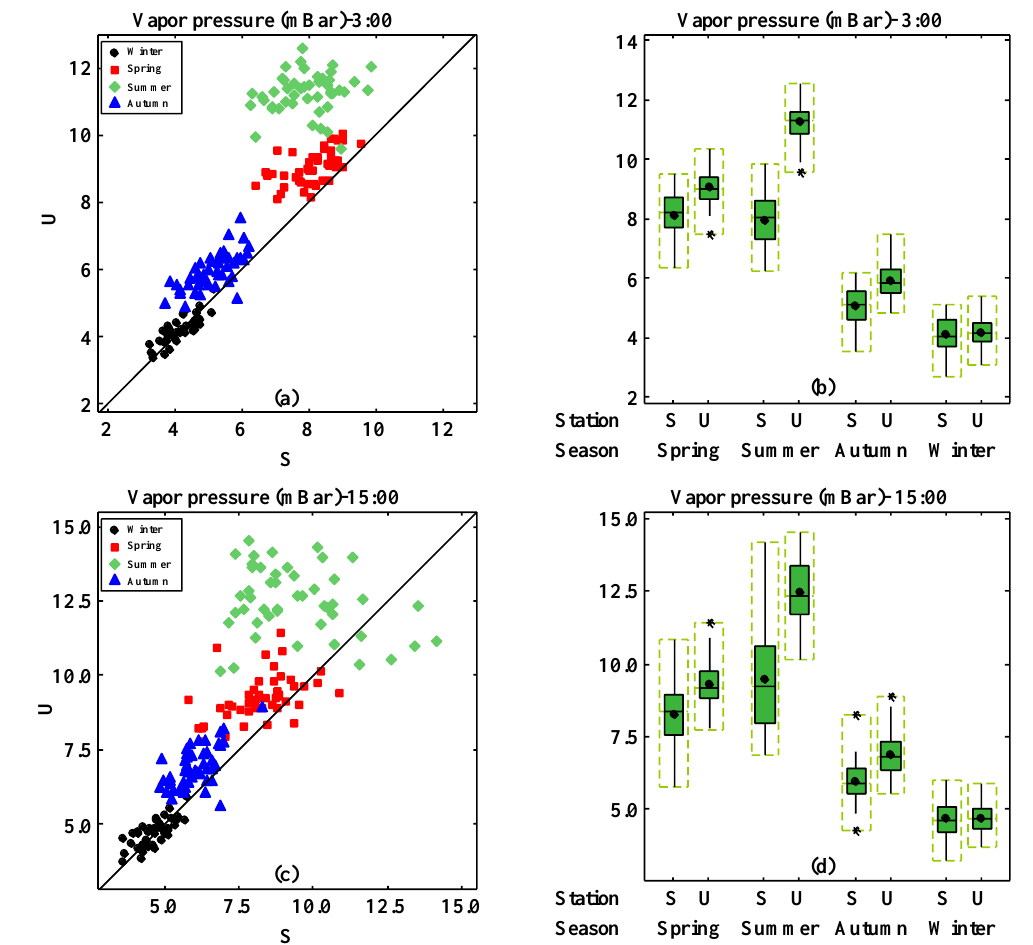
Figure 6. Seasonal patterns in vapor pressure. Scatterplots of vapor pressure at ( a ) 03:00 h and ( c ) 15.00 h in the different seasons at Urmia station (U) and Saqez station (S). ( b , d ) The corresponding boxplots. The seasonal pattern in dewpoint temperature at 03:00 h and 15:00 h (DPT3 and DPT15,